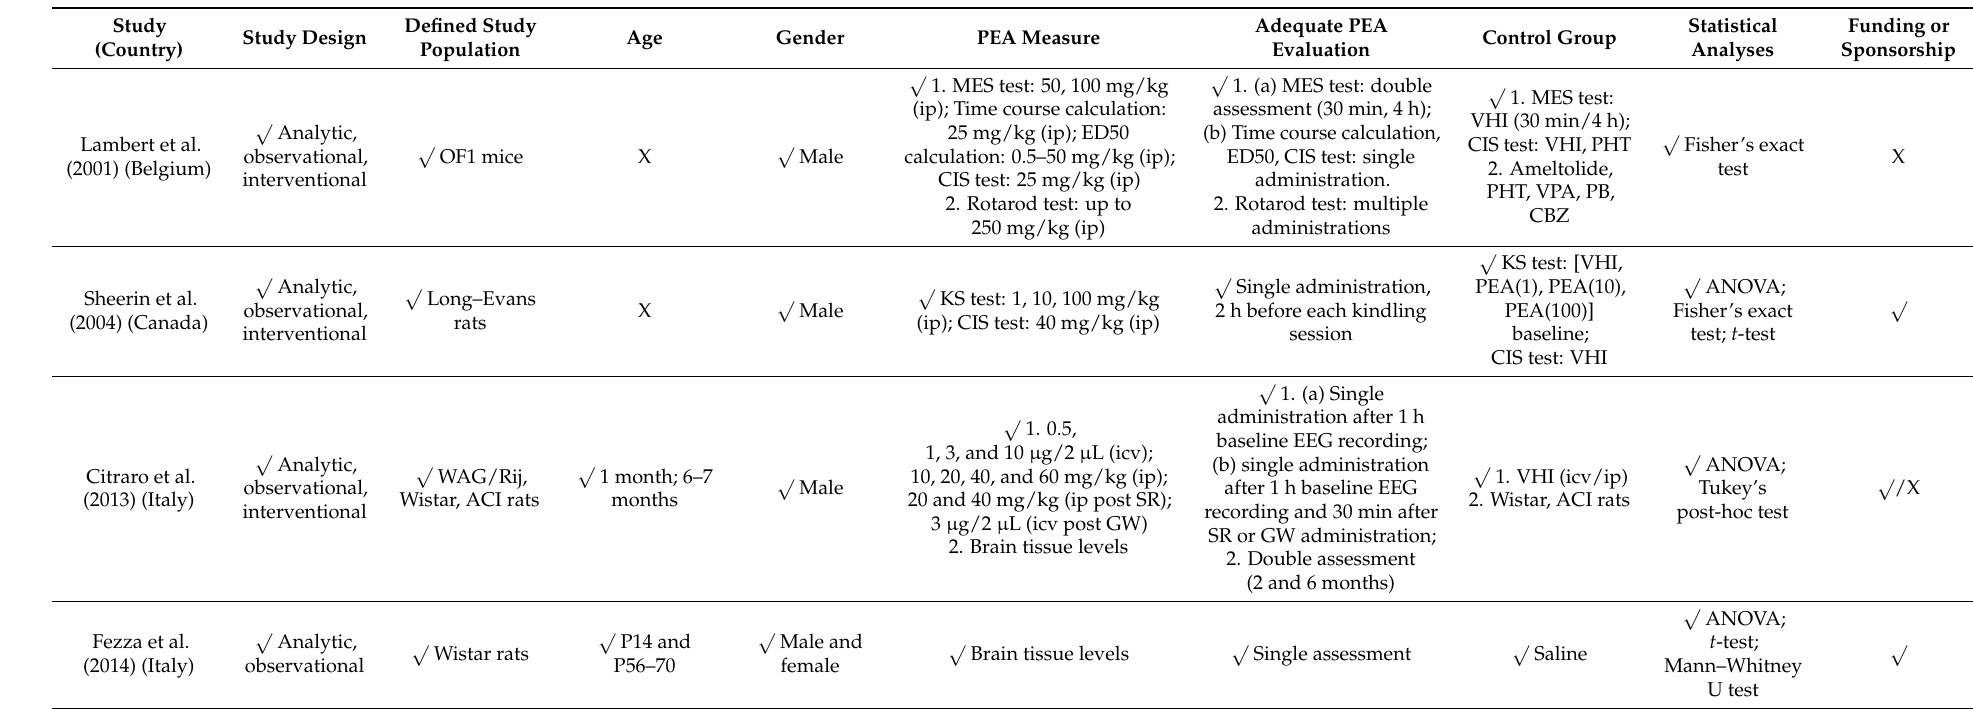
Table 2. Methodological quality of animal studies investigating palmitoylethanolamide and its correlations to epilepsy and acute